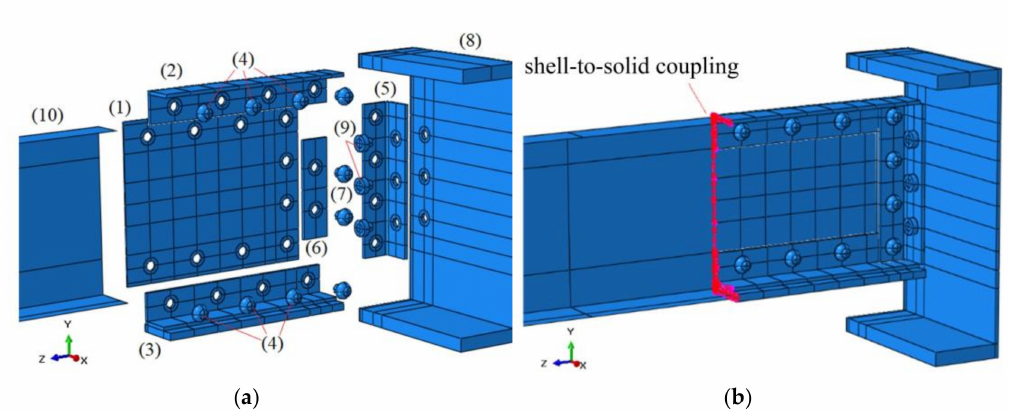
Figure 9. Assembly of the stringer-floor beam connection Finite Element (FE) local model. ( a ) Exploded view of model parts. ( b ) Shell-to-solid